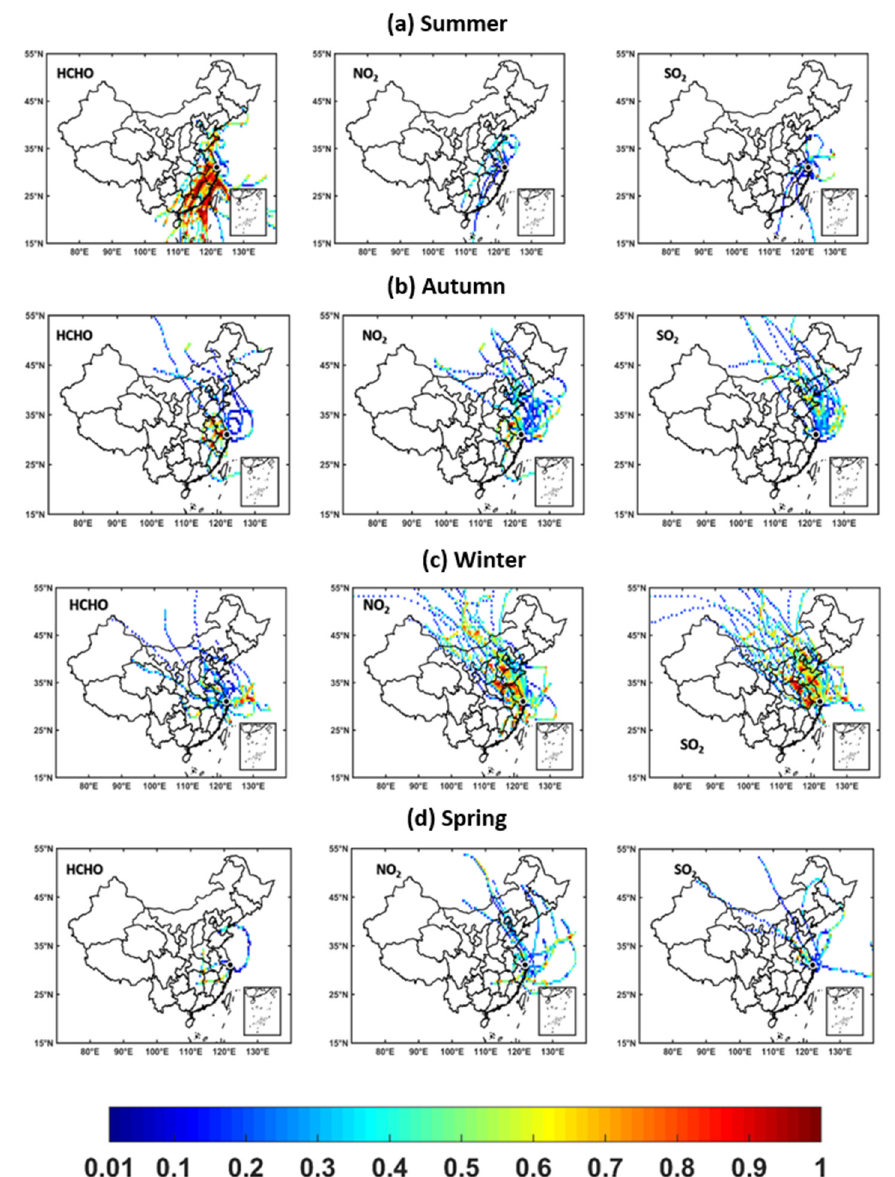
Figure 10. PSCF analysis based on HCHO, NO 2 , and SO 2 , grouped by seasons ( a ) summer, ( b ) autumn, ( c ) winter, and ( d ) spring over Shanghai: Here, the color bar indicates the weights of the pollution source regions (WPSCF). Regions with WPSCF < 0.4 are termed a low-polluted source regions, regions with WPSCF between 0.4 and 0.5 are considered medium-polluted source regions, while the WPSCF > 0.5 indicate high-polluted source regions.